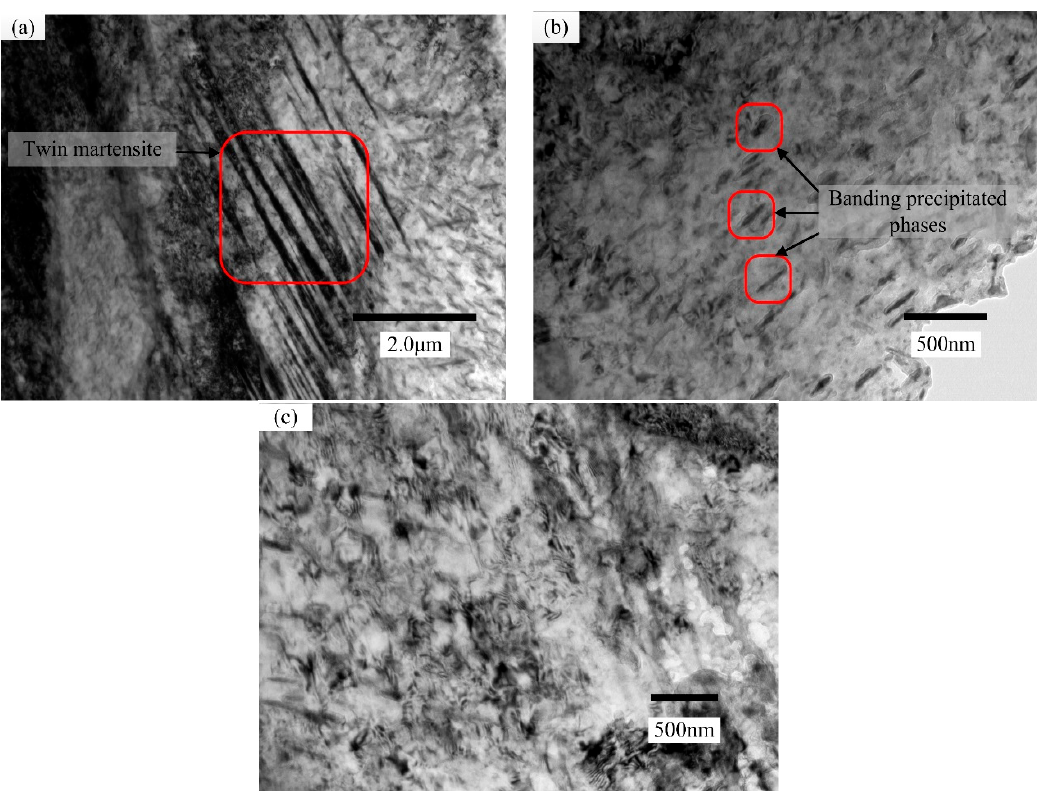
Figure 19. Transmission electron microscopy (TEM) images of pitch point on the tooth flank of gear 2 ‐ 2: ( a ) twin martensite, ( b ) banding precipitated phases, and ( c ) dislocation. Metals 2018 , 8 , x FOR PEER REVIEW 17 of 19